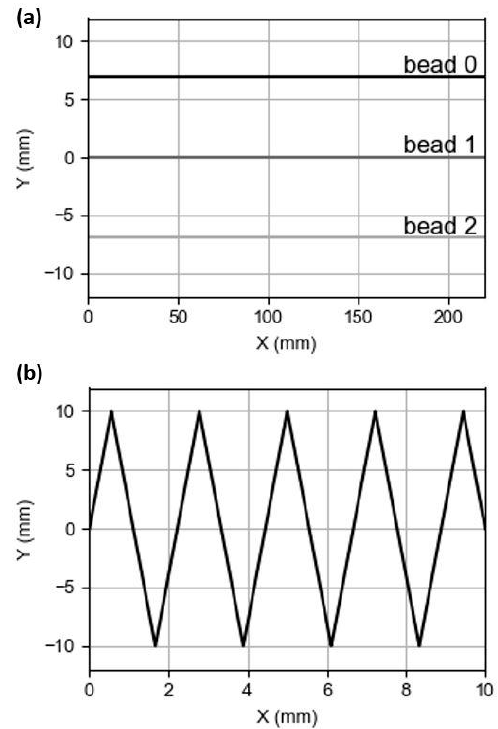
Figure 2. ( a ) Path of the overlapping strategy; ( b ) Path of the oscillatory strategy.